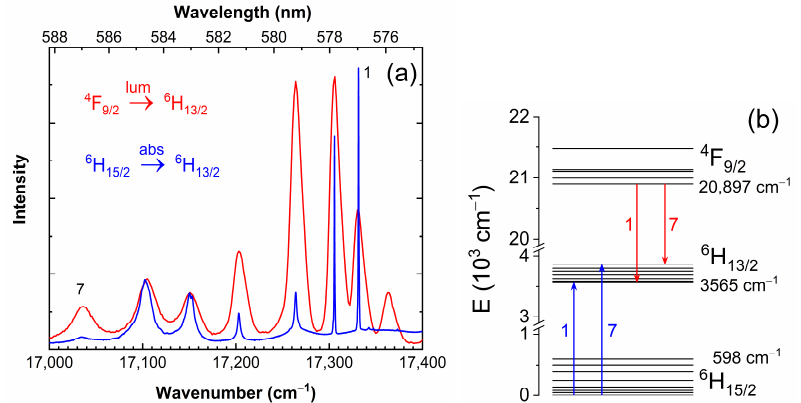
Figure 7. ( a ) The 4 F 9/2 → 6 H 13/2 luminescence transitions at T = 78 K (red line) and the absorption spectrum presented in Figure 3a but reversed as described in the text (blue line). ( b ) Part of the energy levels showing the absorption and luminescence transitions.